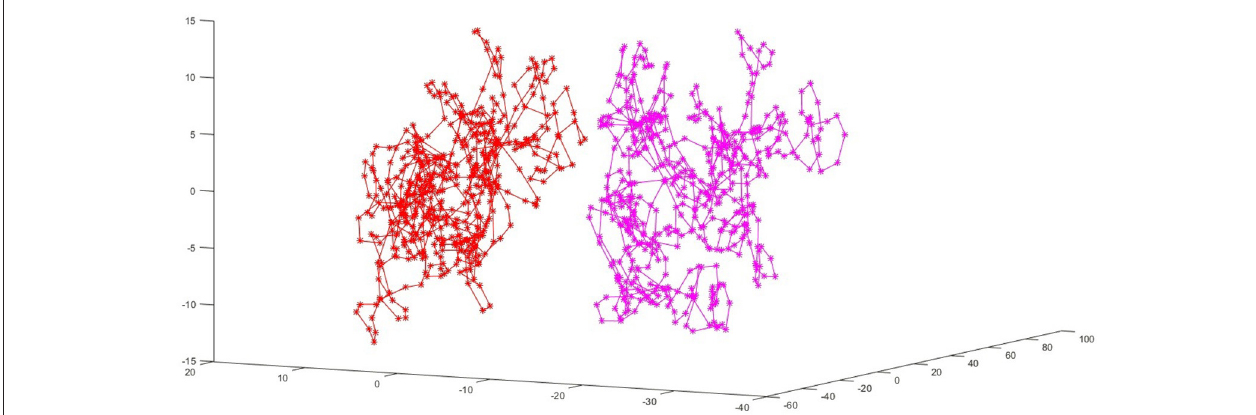
FIGURE 1 | The red voltage samples are taken from the EEG recording before the stimulation, and pink ones from 32min after the tDCS stimulation. The first three principal components of raw EEG samples before and after tDCS stimulation are illustrating that they belong to separate parts of the phase space. Here is a PCA plot for person number 8, with cathodal (C) stimulation. This figure is part of results published in Chapter 3 in book ( ˇ Cuki´c Radenkovi´c, 2019), but this particular PCA plot is not displayed before (due to limited space in previous